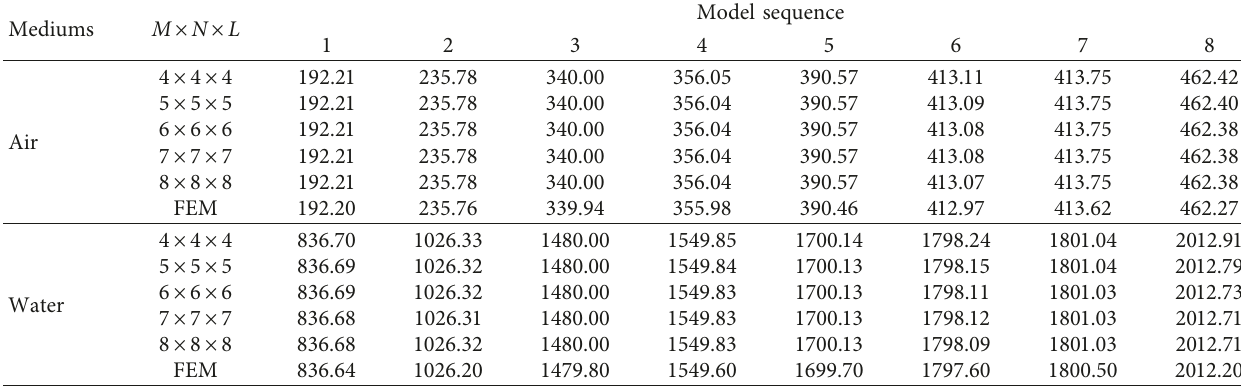
Table 1: The convergence analysis of the first eight natural frequencies (Hz) of the triangular prism acoustic cavity.